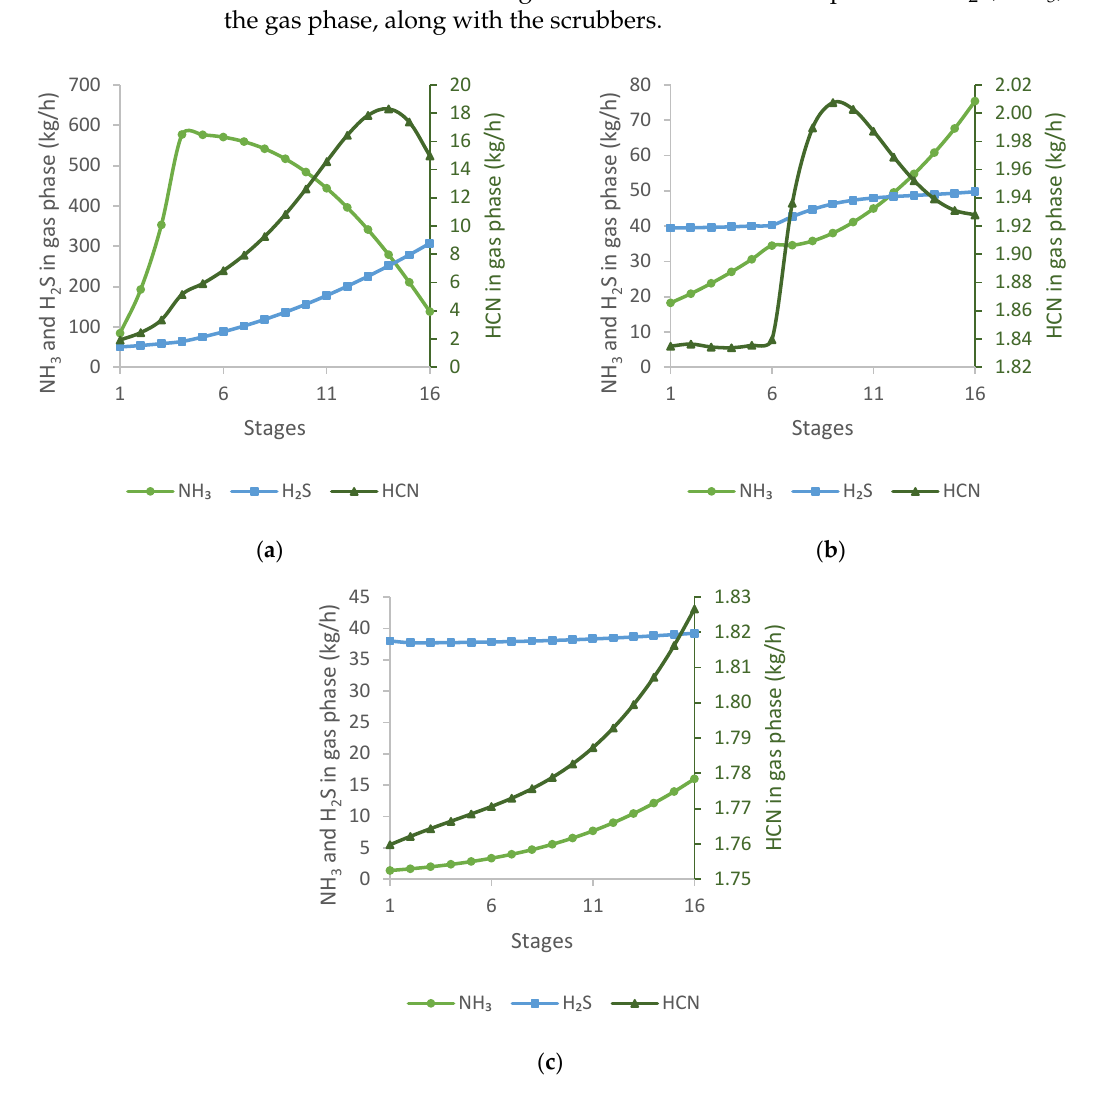
Figure 4. Mass flow profiles of main impurities in the gas phase in ( a ) H 2 S scrubber, ( b ) NH 3 scrubber, ( c ) fine NH 3 scrubber.